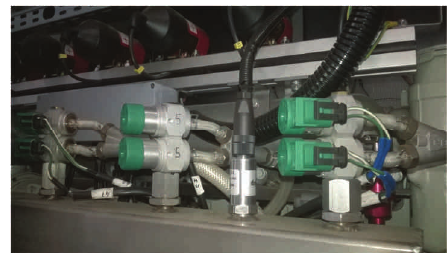
Fig. 3. Post-process gas fuel supply system of 12-cylinder